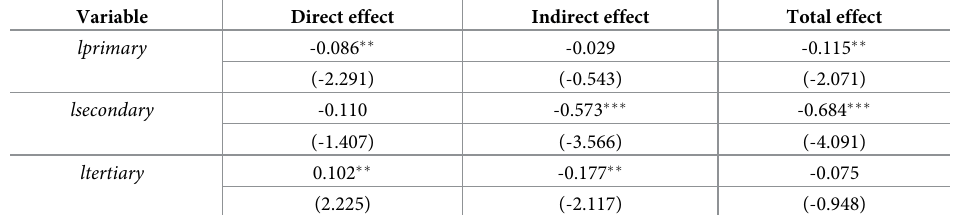
Table 6. Spatial effect decomposition table of SDM under space-time two-dimensional fixed effects of high-qual- ity economic